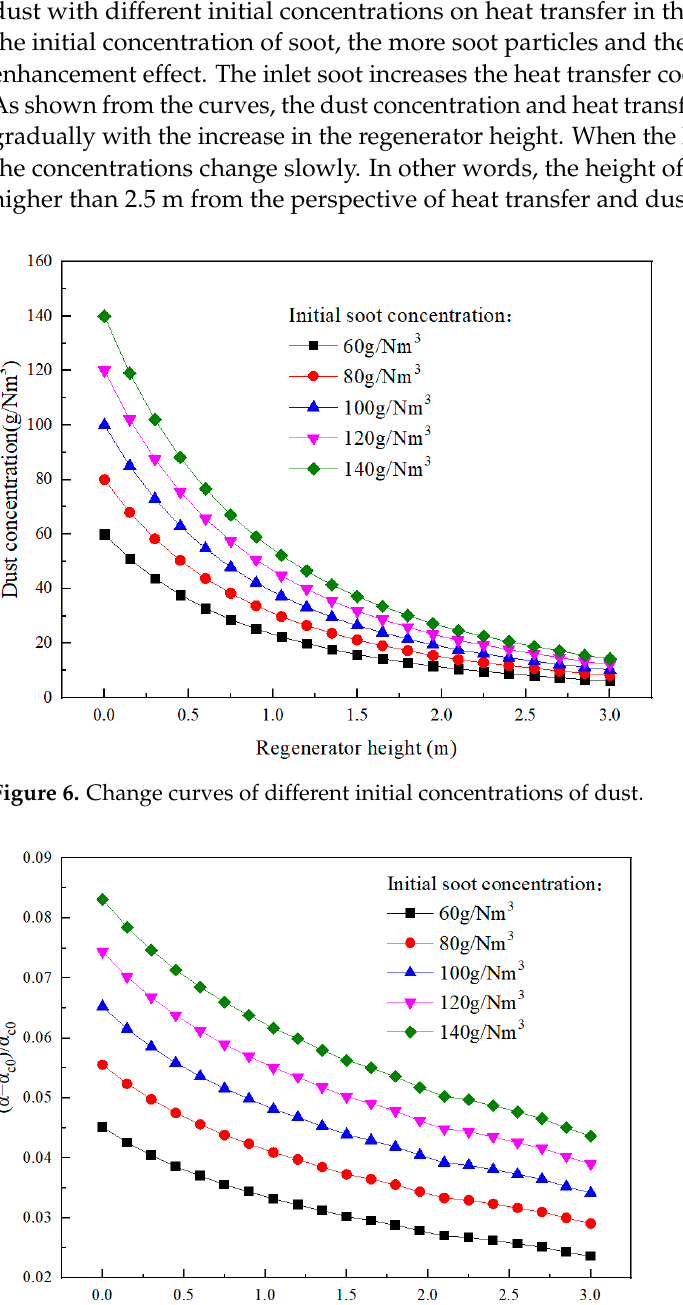
Figure 5. Effects of different diameter dust on heat transfer.